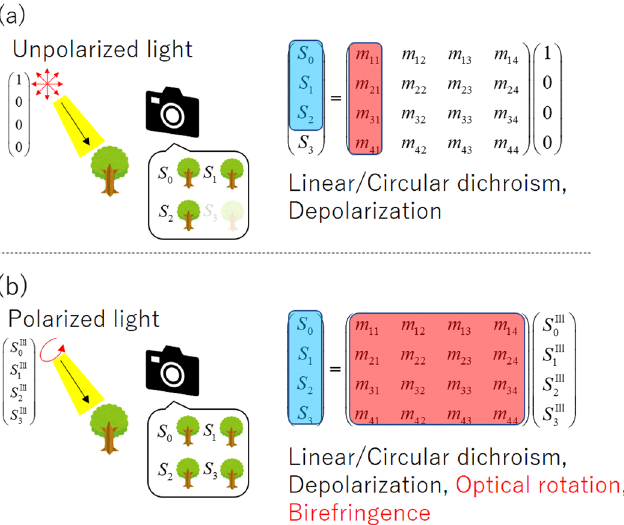
Figure 1. Description of polarization conversion based on the Muller matrix formula. ( a ) Conventional approach for measurement of the Stokes parameters S 0 , S 1 , and S 2 under unpolarized light illumination whose Stokes vector is ( 1, 0, 0, 0 ) . ( b ) PPPI approach for measurement of the Stokes parameters S 0 , S 1 , S 2 , and S 3 under polarized light illumination whose Stokes vector is (cid:31) S Ill 0 , S Ill 1 , S Ill 2 , S Ill 3 (cid:30)